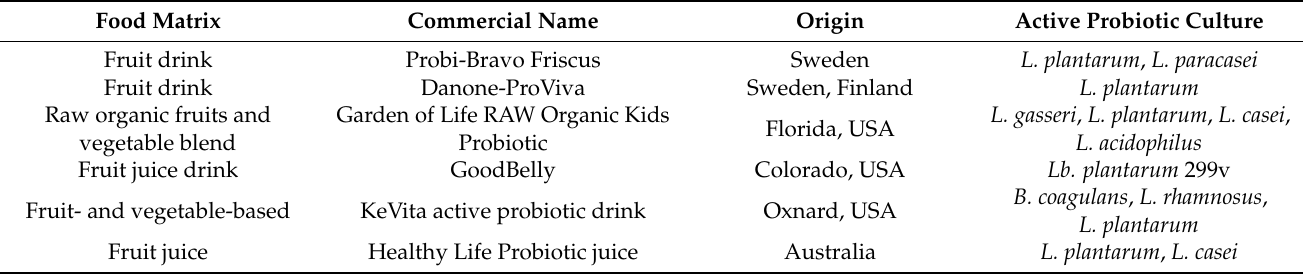
Table 2. Global commercial probiotic products based on fruit matrices fermented by probiotic L. plantarum. Source: